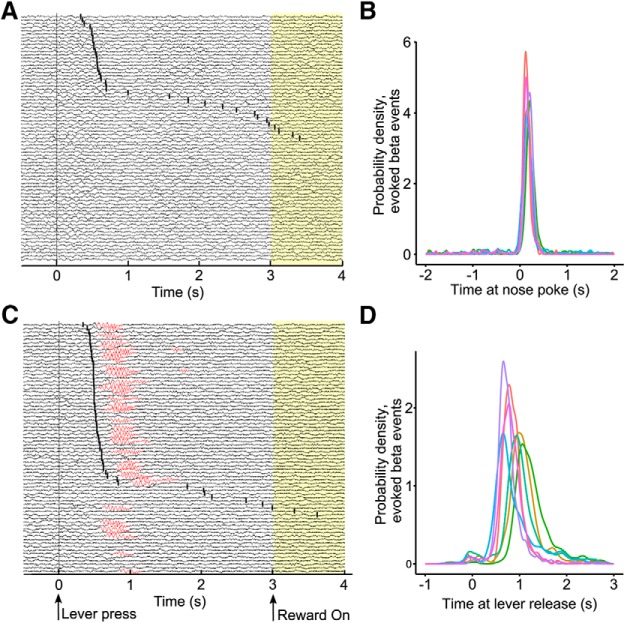
β Oscillations do not correlate with reaction times, but with nose pokes in the food area. A, Young rat example of LFP traces recorded over the 70 session trials, from a reward magnitude discrimination task, sorted by reaction time (nose poke at the reward zone, black tick mark). Yellow background indicates reward delivery at 3-s post-lever release (delivery duration: 0.5 s for small, 0.5–2 s for the variable magnitude reward). B, Probability density function of the timing of β epochs aligned at 0 at the nose poke in the food area, for each aged rat (denoted by the different colors). C, Same as A, in an old rat. Red portion of traces indicate β-band oscillation occurrence. D, Same as in B, with the data aligned at 0 at the lever press.